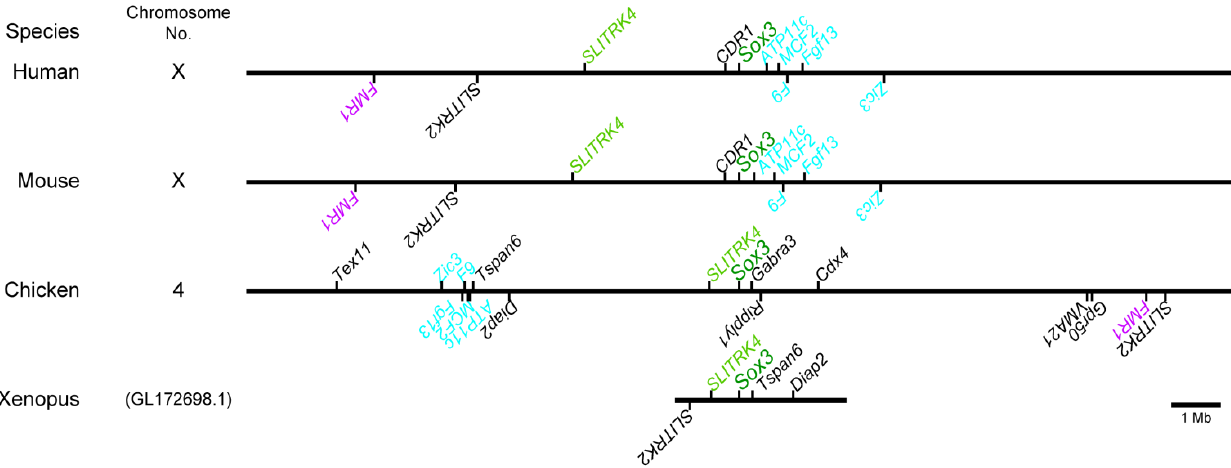
Figure S1. The arrangement of genes surrounding the Sox3 locus in human, mouse, chicken and Xenopus tropicalis . The landmark genes are highlighted in different colors, indicating the occurrence of extensive rearrangements of the chromosomal segments among the animal species